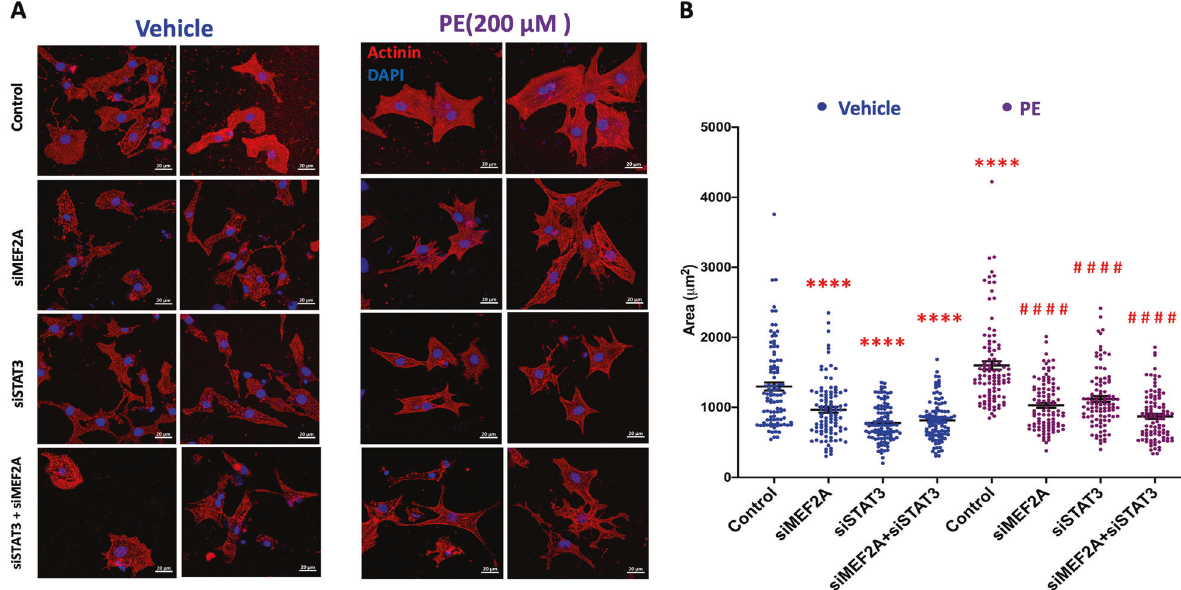
Fig. 8 MEF2A/STAT3 complex is involved in biological processes in myocardial cells. A MEF2A and STAT3 are involved in the increase of cardiomyocyte surface area in response to phenylephrine. Immuno fl uorescence analysis of α -Actinin and DAPI was performed in PCMs transfected with siRNA targeting MEF2A and STAT3 individually and in combination for 48 h then treated with PE (200 μ M) or vehicle (H 2 O) for a further 48 h. The fi gure illustrates 2 representative images for each condition. The scale bar is 20 μ m. B The scatter plot represents the quanti fi cation of the surface area of α -Actinin-positive cells using Image J software. The blue dots represent PCMs treated with H 2 O and purple dots represent the PCMs treated with PE. The data presented are derived from the surface areas of 100 cells that were randomly selected from four biological replicates (25 cells per biological replicate). Each cell surface area measurement is represented as a dot in each condition and the mean is indicated by a horizontal line. Tukey ’ s Multiple comparisons test in one-way ANOVA using GraphPad Prism 8.0 was used to test for statistical signi fi cance. * represents statistical signi fi cance from control vehicle-treated group. # represents statistical signi fi cance from PE-treated group. Adjusted p -value * ≤ 0.05, ** ≤ 0.01, *** ≤ 0.001, ****<0.0001, comparing to